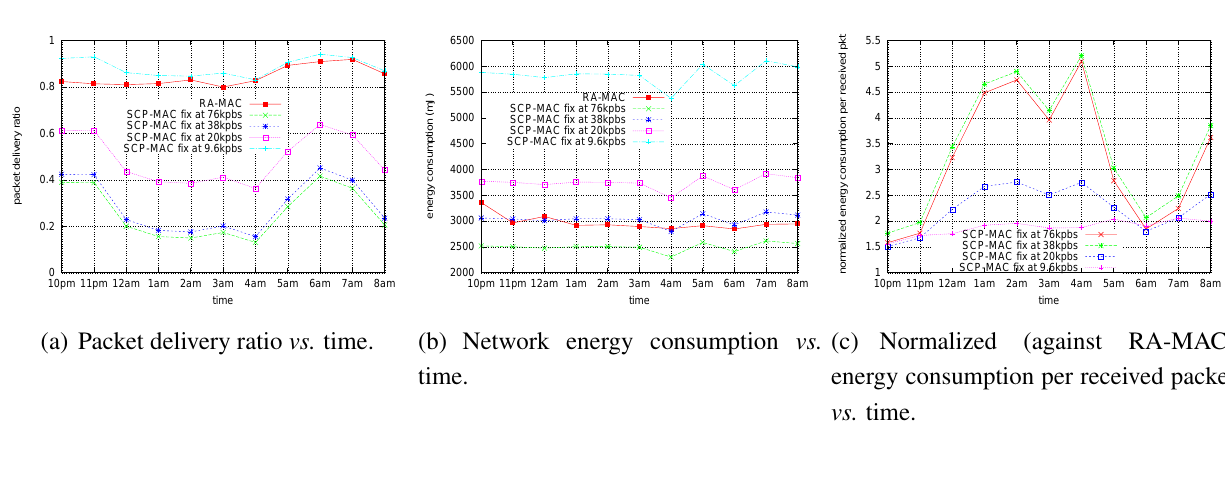
Figure 8 . Two hops network (one packet every